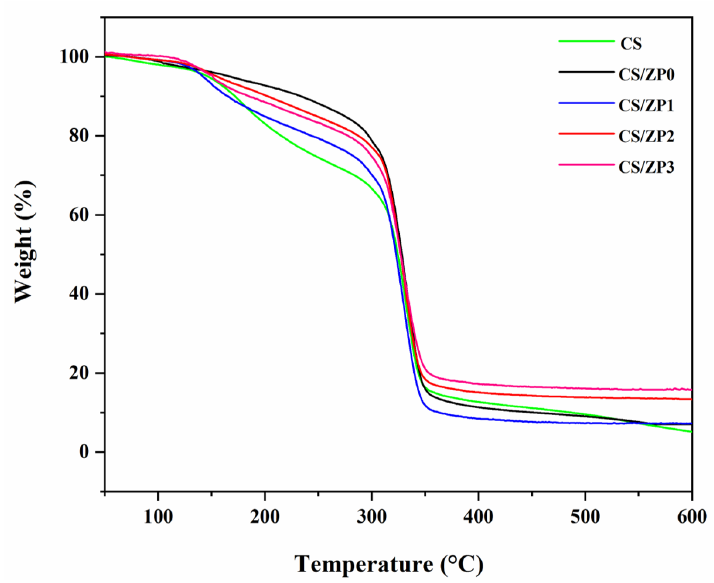
Figure 6. Thermogravimetric analysis of the neat CS film and bionanocomposite film